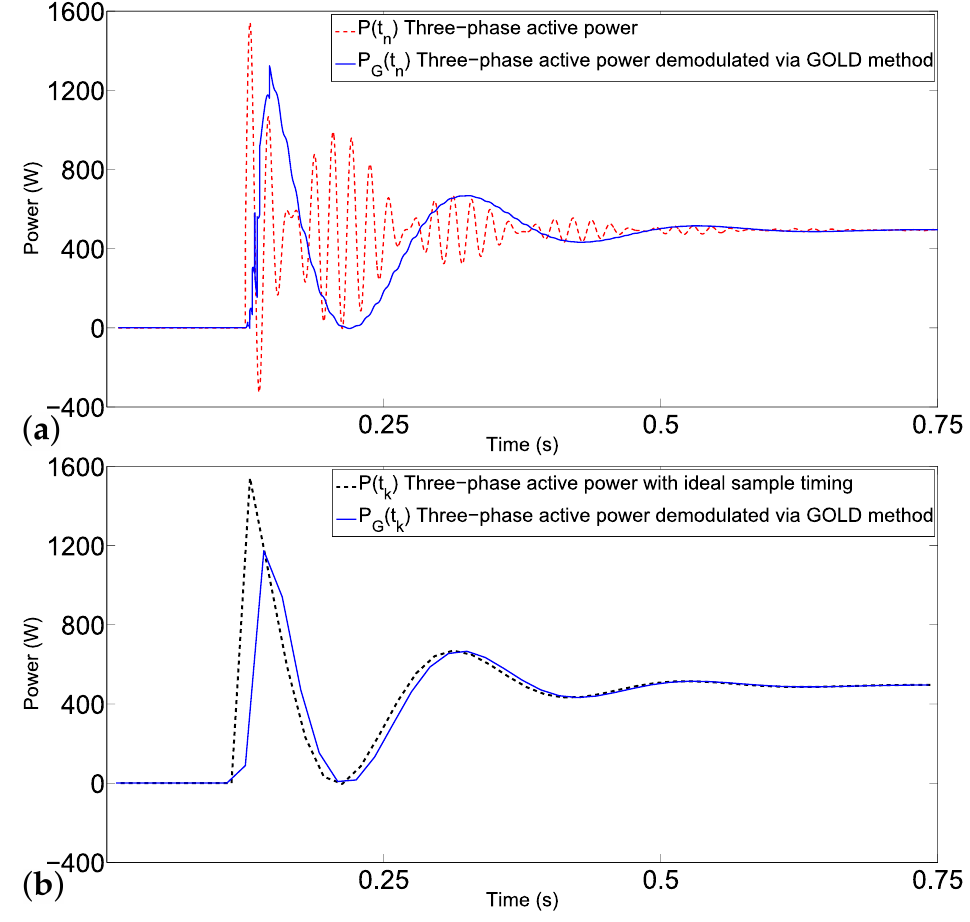
Figure 8. Simulated performance of the GOLD method, ( a ) comparing actual computed power disturbance with demodulated power disturbance, and ( b ) comparing of the envelope to down-sampled demodulated